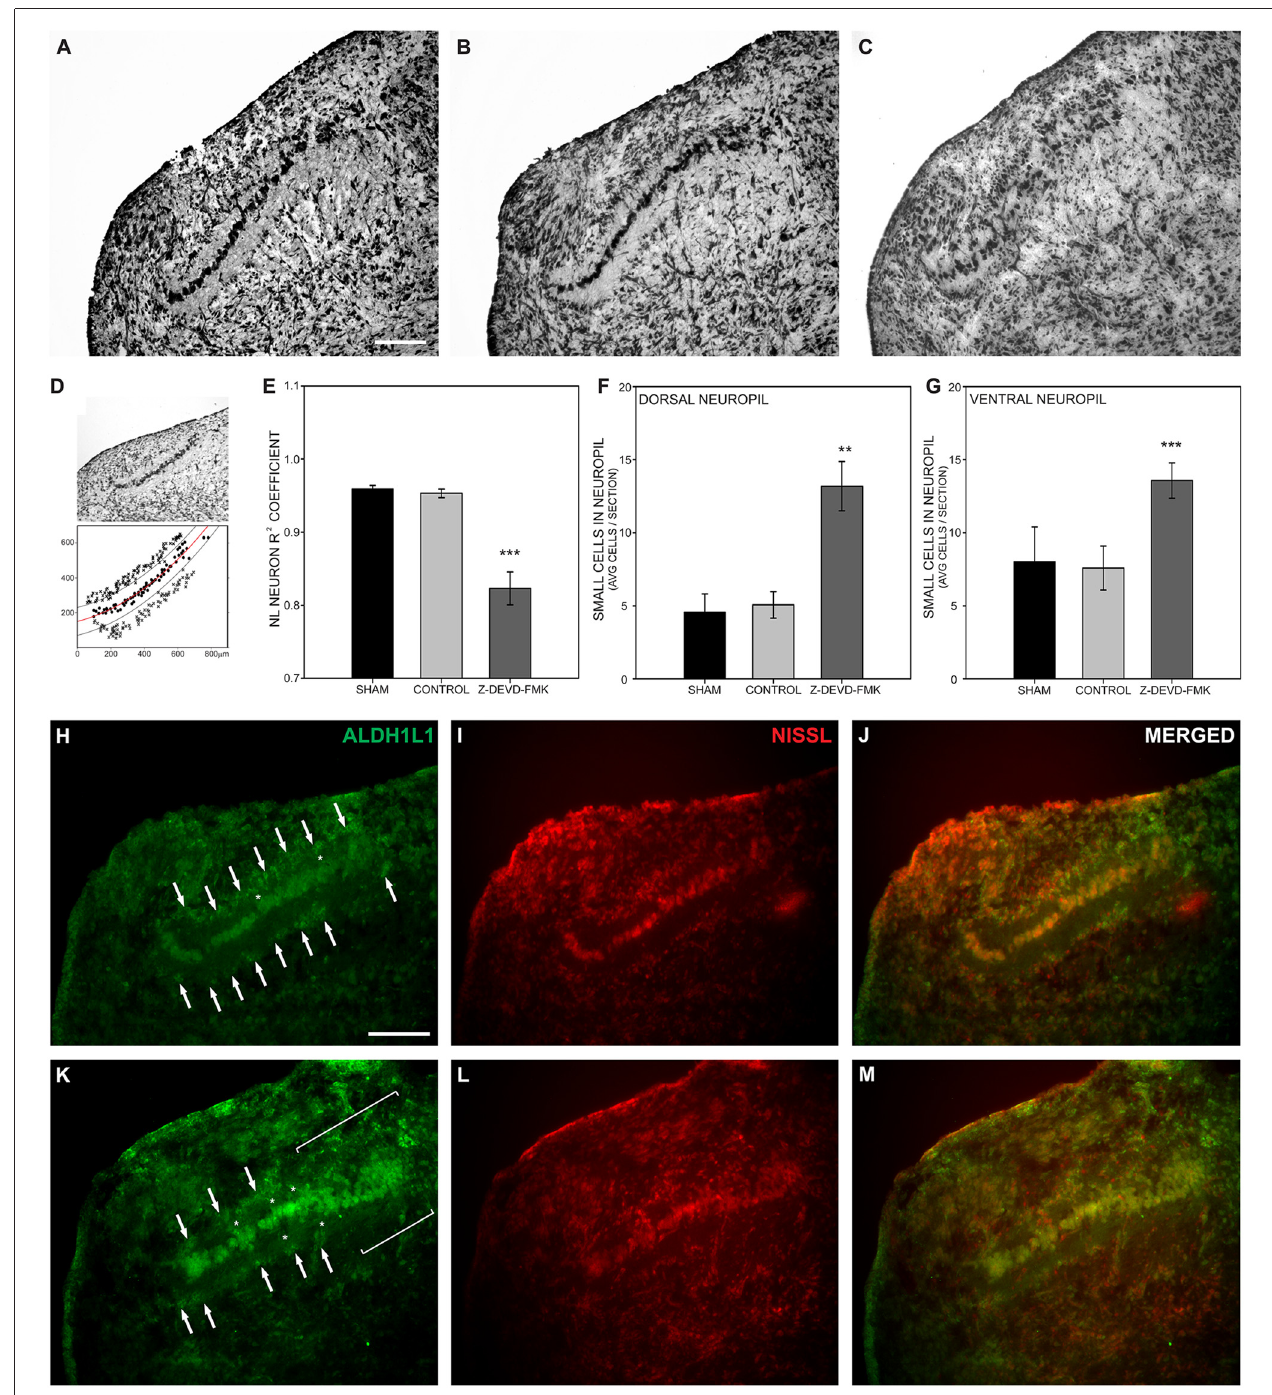
FIGURE 4 | Loss of cleaved caspase-3 impairs NL lamination. (A) NL lamination appeared normal in Nissl stained sections from sham injected embryos and (B) control embryos. (C) In Nissl stained sections from Z-DEVD-FMK injected embryos, disruption of the NL lamina and surrounding cell-free neuropil was evident. (D) The extent of NL neuronal disarray was described using R 2 coefficients and by quantifying the extent of small cells permitted into the normally cell-free dendritic zone of NL. R 2 coefficients were found by assigning X − Y coordinates to NL neurons (black circles) and drawing a regression line through those points (red line). Lines parallel to the regression line were drawn 40 µ m dorsal and ventral to the regression line to delineate the cell-free neuropil ended (black lines). The number of small cells ( x ’s) that normally remain outside the cell-free neuropil were quantified in control and treated embryos. (E) The Z-DEVD-FMK injected group had significantly lower R 2 coefficient values ( ∗∗∗ p < 0.001, one-way ANOVA), reflecting more neuronal disorganization. (F,G) Significantly more cells intruded into the